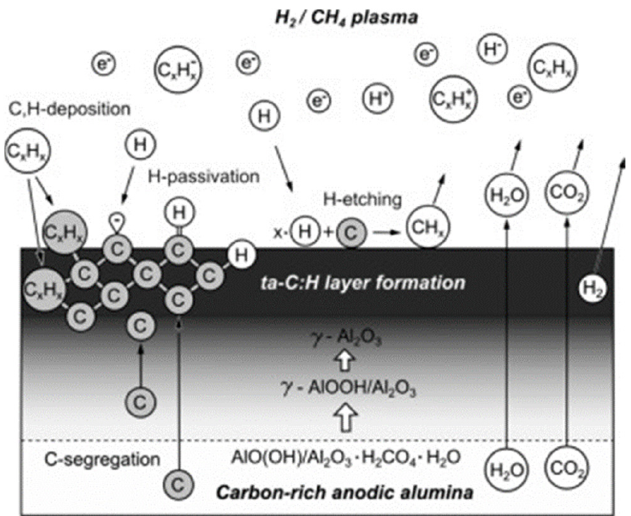
Figure 23. Schematic representation summarizing the growth and nucleation of the ultrathin DLC layer inside and within the alumina surface as proposed by Aramesh et al. [215]. Reprinted with permission from ref. [215]. Copyright © 2023 Elsevier Ltd. All rights reserved.